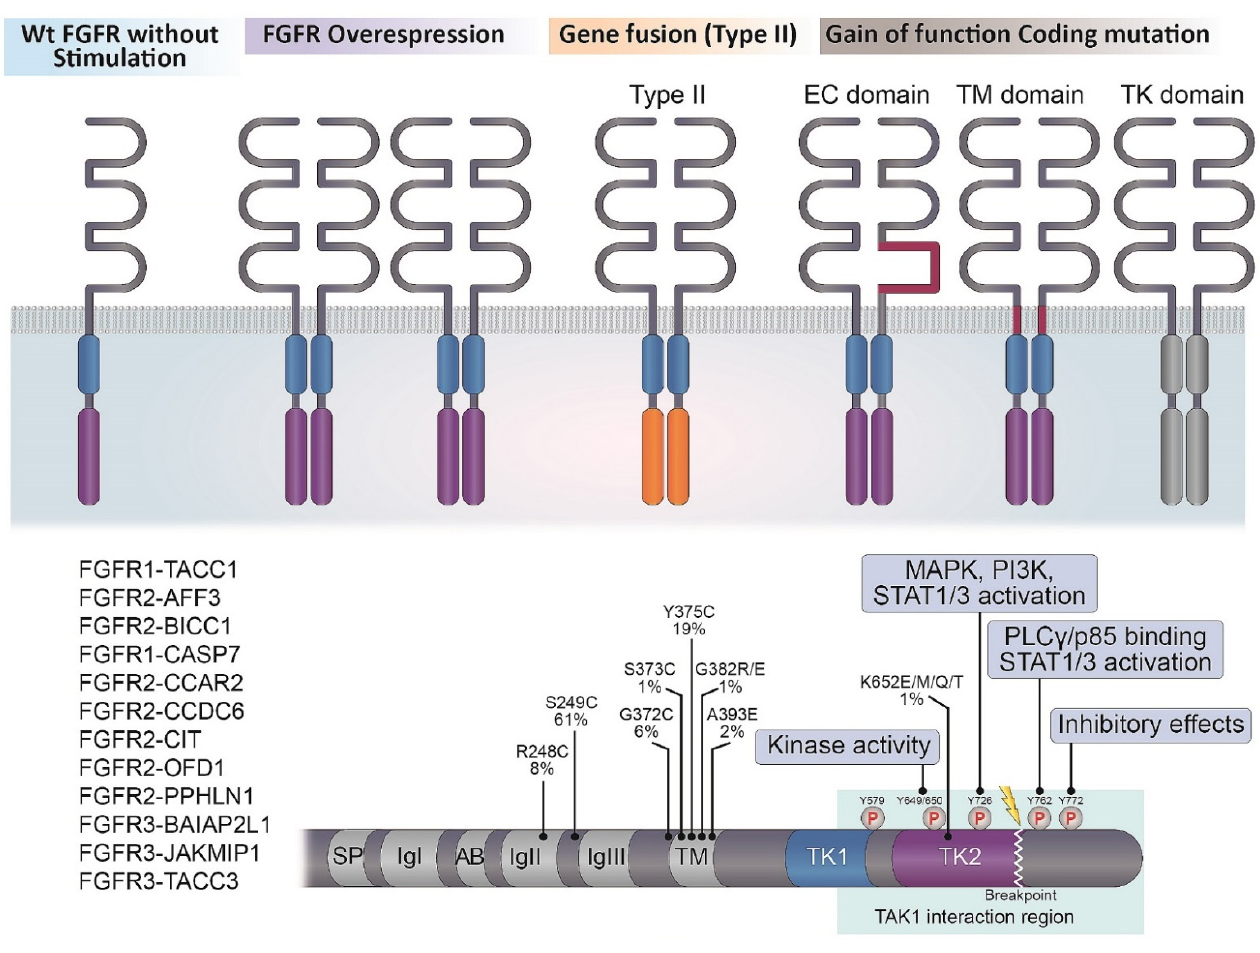
Figure 1. The mechanisms of activated FGFR signaling activity in a/m UBC. The canonical and endocrine FGFs produce their biological actions by signaling through FGFR1-4, which are consisted of three extracellular (EC) parts, a transmembrane domain (TM) and two intracellular (IC) tyrosine kinase domains (TK1 and TK2). Wt = wild type